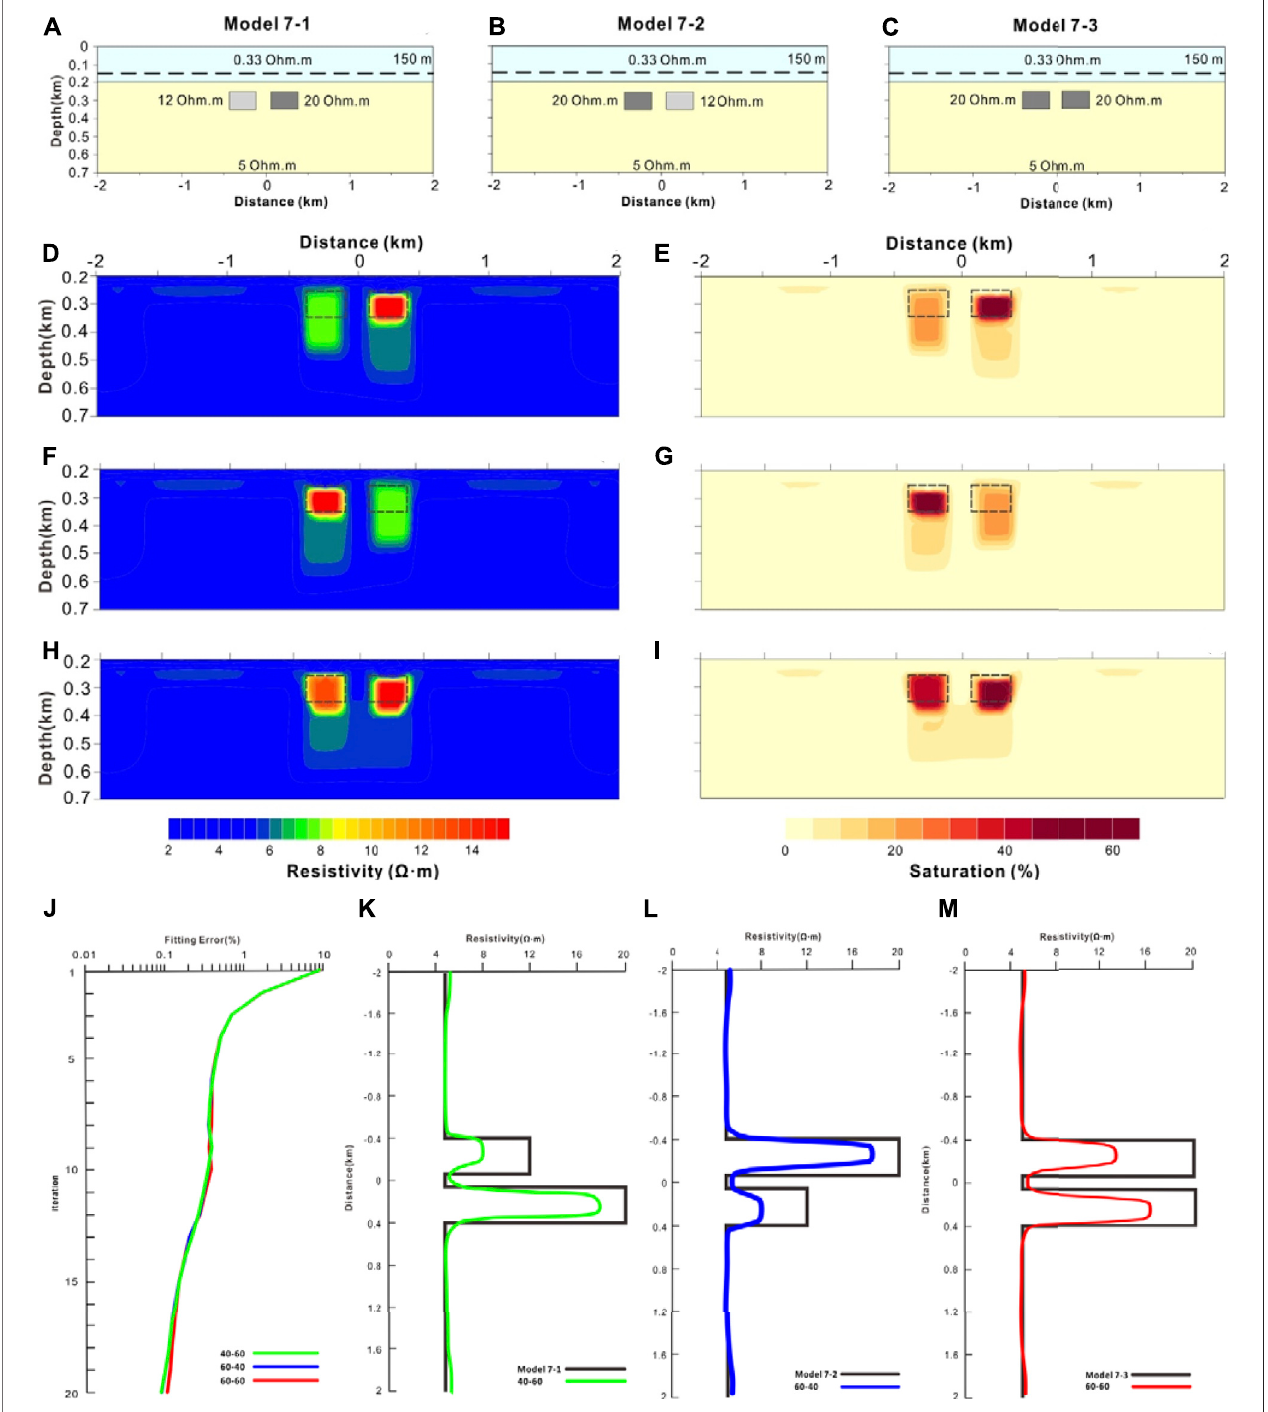
FIGURE 10 | Resistivity inversion and hydrate saturation estimation of various horizontal distribution combination models of hydrate reservoir. (A) – (C) : the schematic diagram of Model 7 – 1, 7 – 2, and 7 – 3 respectively, light blue indicates seawater, light yellow indicates marine sediments, gray block indicates hydrate reservoirs,dottedlineindicatesthetrackofthetowedDCRarrayarrangement; (D) , (F) and (H) :theinversionofModel7 – 1,7 – 2,and7 – 3respectively; (E) , (G) and (I) :the hydrate saturation of Model 7 – 1, 7 – 2, and 7 – 3 respectively (J) the inversion iteration convergence of Model 7 – 1(green), 7 – 2(blue) and 7 – 3 (red), respectively (K) – (M) : the resistivity pro fi le with depth at the center x position of hydrate reservoir of Model 7 – 1(green), 7 – 2(blue) and 7 – 3 (red), respectively.